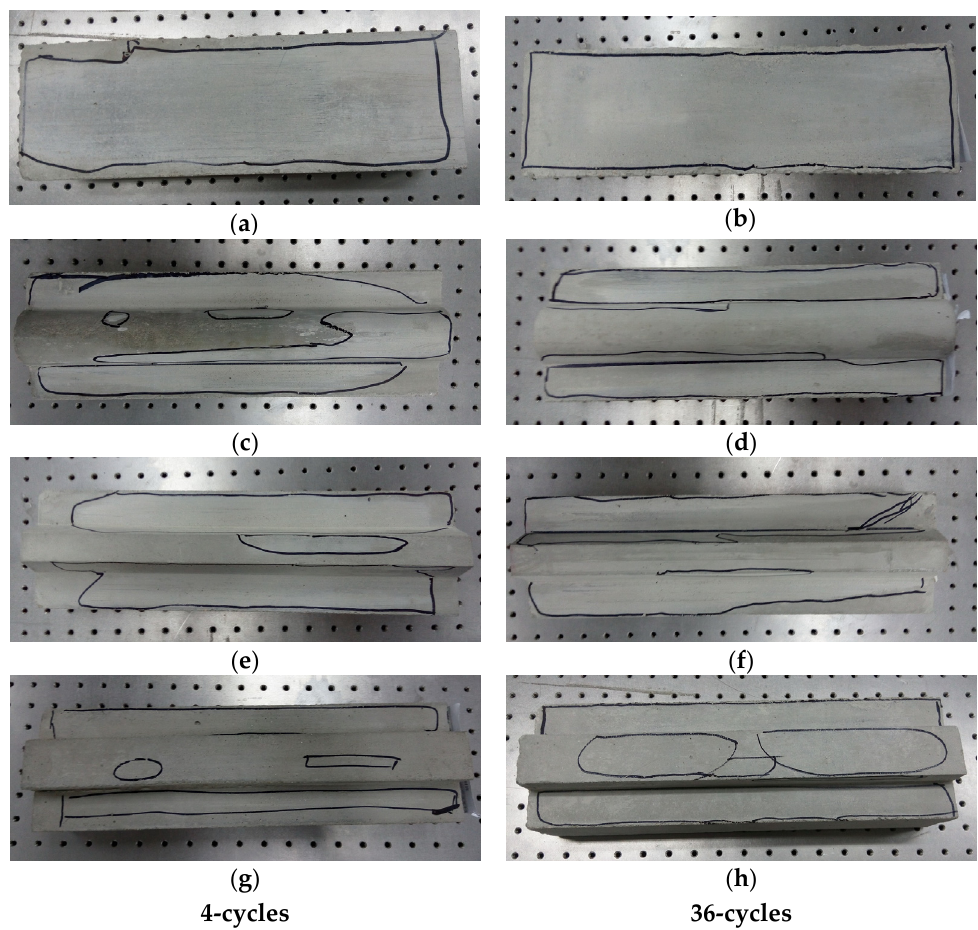
Figure 11. Photos of the wear condition for N ‐ IMBs and IMBs after different loading cycles. ( a ) N ‐ IMBs after four cycles; ( b ) N ‐ IMBs after 36 cycles; ( c ) circular IMBs after four cycles; ( d ) circular IMBs after 36 cycles; ( e ) trapezoidal IMBs after four cycles; ( f ) trapezoidal IMBs after 36 cycles; ( g ) rectangular IMBs after four cycles; ( h ) rectangular IMBs after 36 cycles.